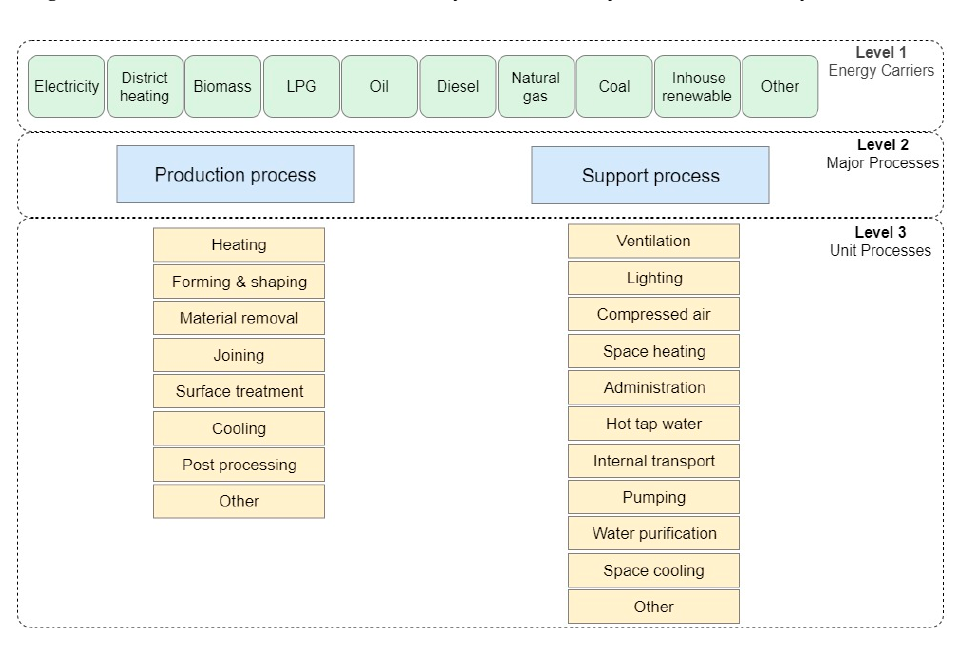
Figure 6. Process tree showing Level 4 production categories of energy use taxonomy in the engineering industry.